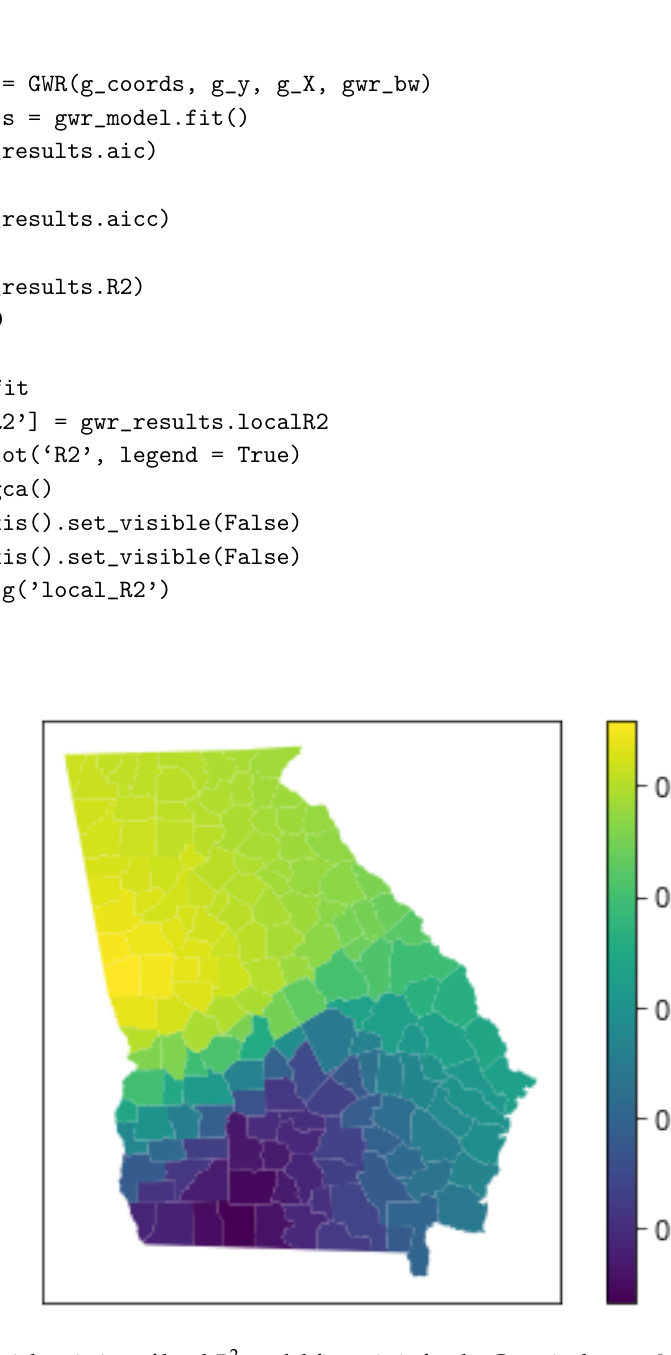
Figure 6. Spatial variation of local R 2 model fit statistic for the Georgia dataset. Model fit is highest in the north, and worst in the